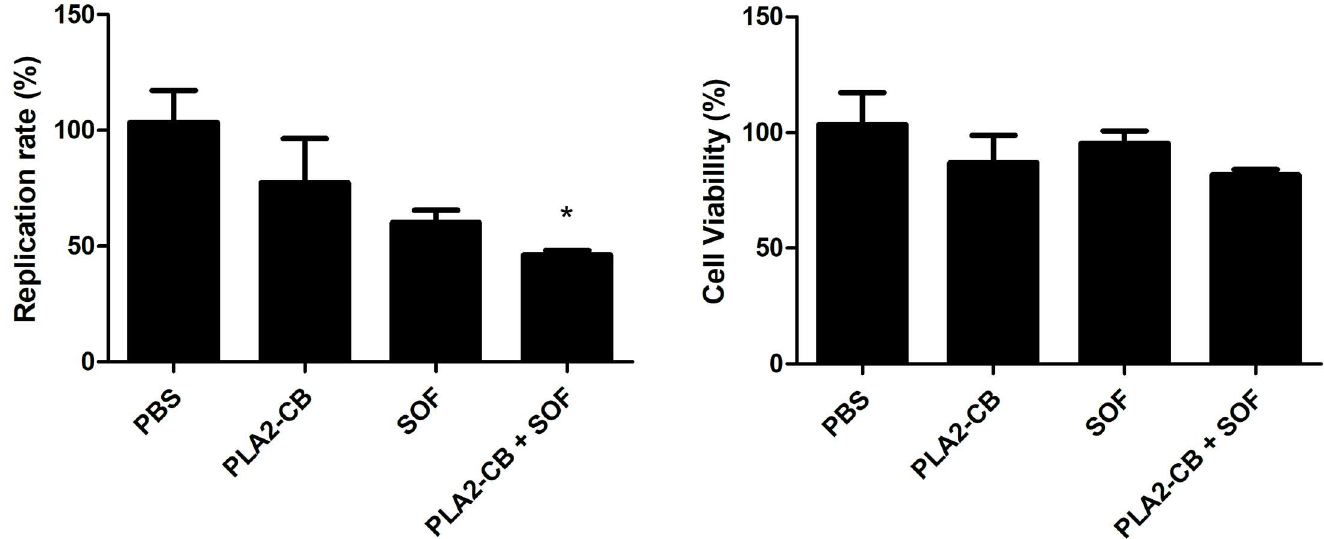
Fig 5. Sofosbuvir and PLA 2 -CB combined treatment. Huh-7.5cells stably harboringthe SGR-Feo-JFH-1 were seededinto 96-wellplates and treated with PLA 2 -CB, Sofosbuvir or the combination PLA 2 -CB and Sofosbuvir for 48 h. After the treatment replicationlevel (A) and cell viability (B) were measured. P < 0.001 was considered significant( * ).